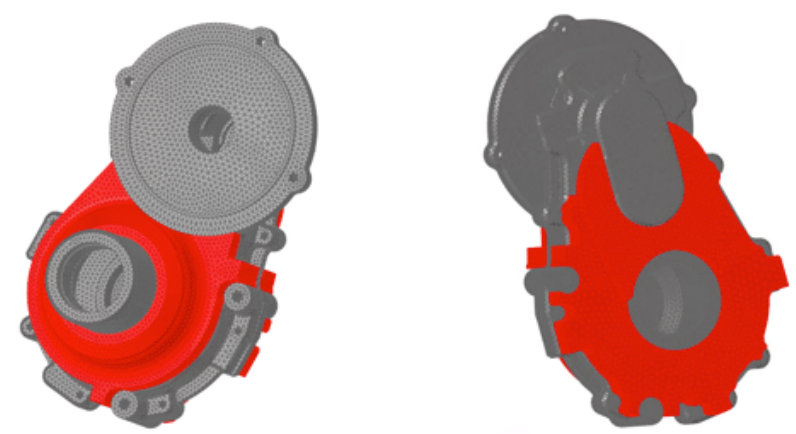
Figure 16. New design area (red) for optimization.